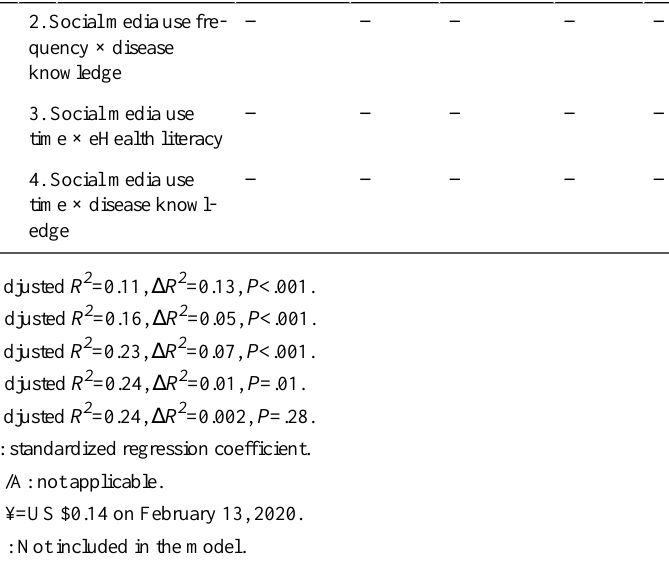
Figure 2. Simple slope test of the moderating effect of eHealth